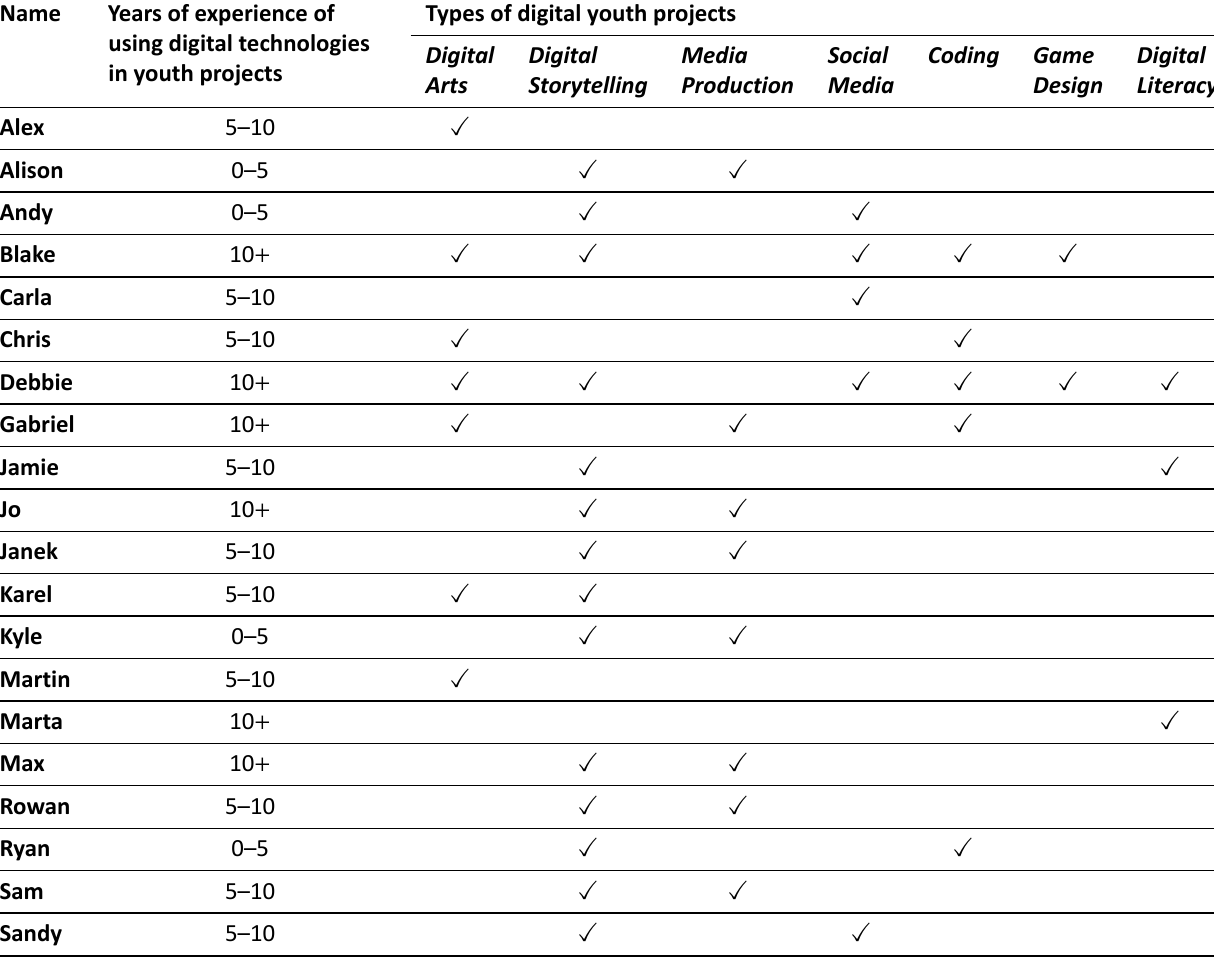
Table 1. Study participant’s subset data and digital youth projects categories, as coded by the authors of this article.